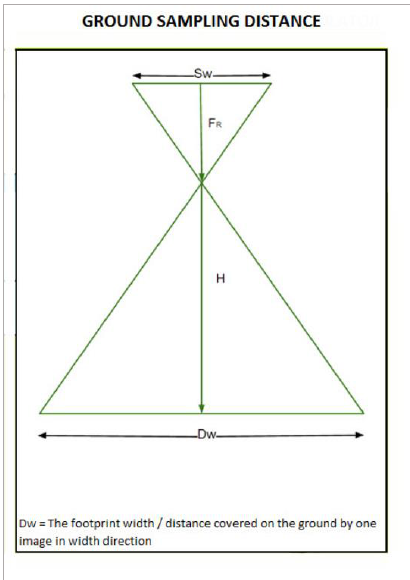
Figure 14. Ground Sampling Distance